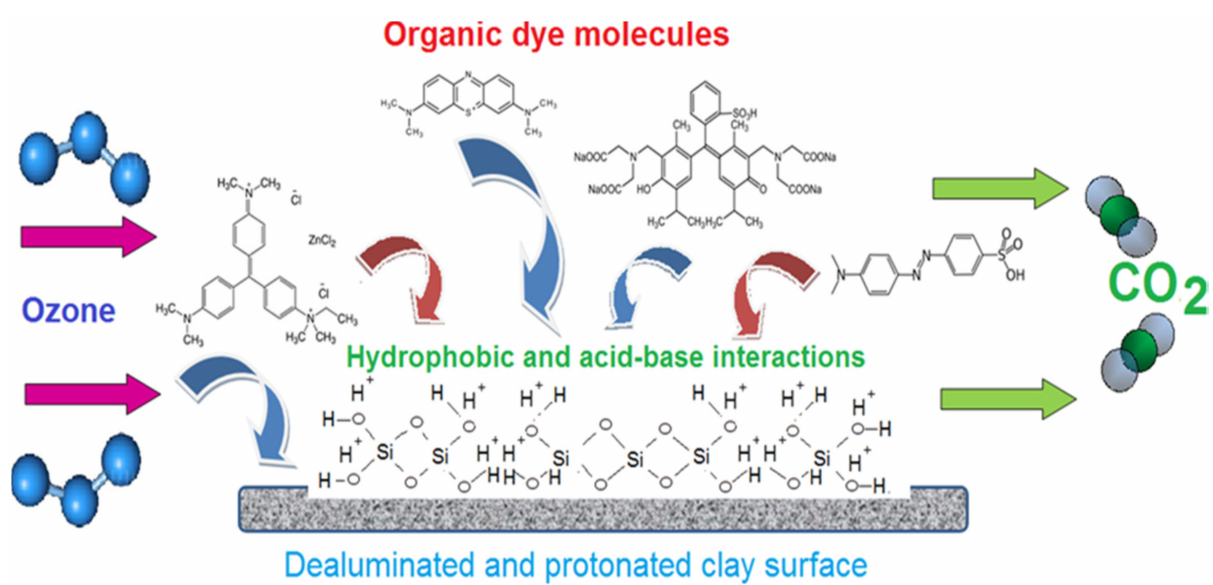
Figure 7. Mechanism of catalytic ozonation on the dealuminated and protonated clay surface. Reprinted with permission from Ref. [79].